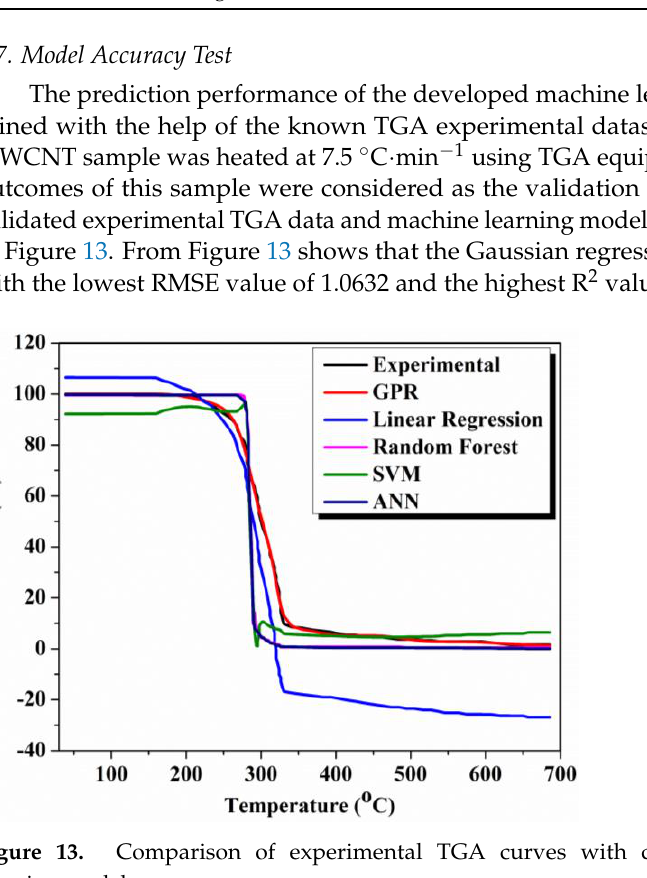
Table 3. Sensitivity analysis of developed machine learning models.